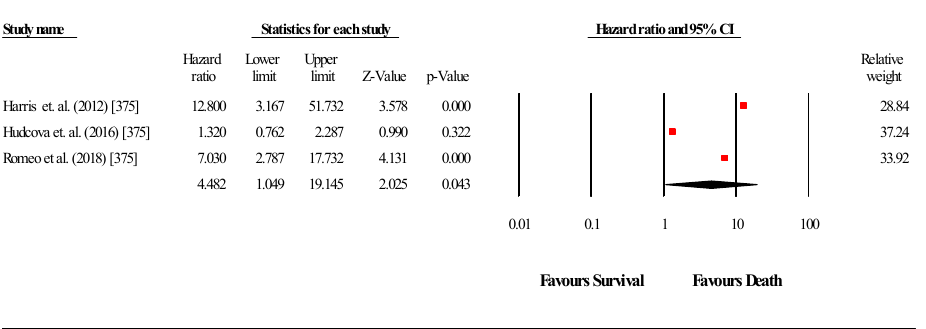
Figure 11. Forest plot for miR-375 association with OS.